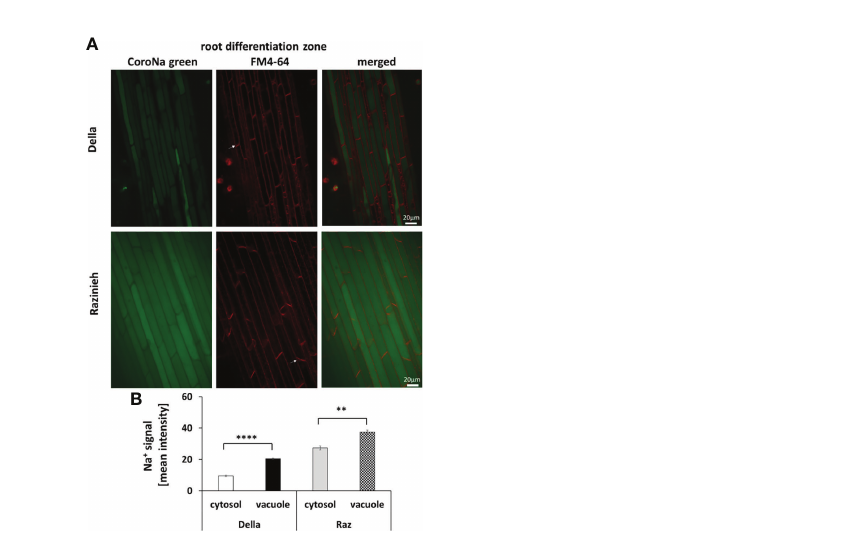
FIGURE 7 Na + signal intensity in the cytosol and vacuole in the root differentiation zone of 4-day-old sorghum seedlings grown in darkness were treated with 100 mM NaCl for 24 (h) (A) Representative images of root differentiation zone of Della and Razinieh genotypes, cells stained with CoroNa Green dye, and FM4- 64 dye. (B) Averaged pooled values for Na + signal intensity in the cytosol and vacuole in the root differentiation zone. Mean ± SE [ n = 37 (Della) and 47 (Razinieh)]. Asterisks indicate a statistically signi fi cant difference between treatment and corresponding control, as determined by Student ’ s t -test (** p < 0.01, **** P <